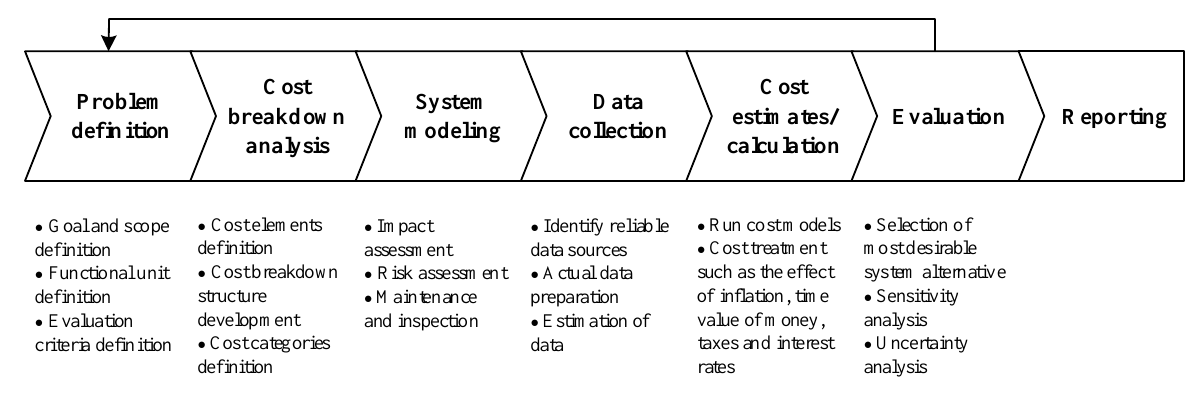
Figure 3. LCC framework [42].